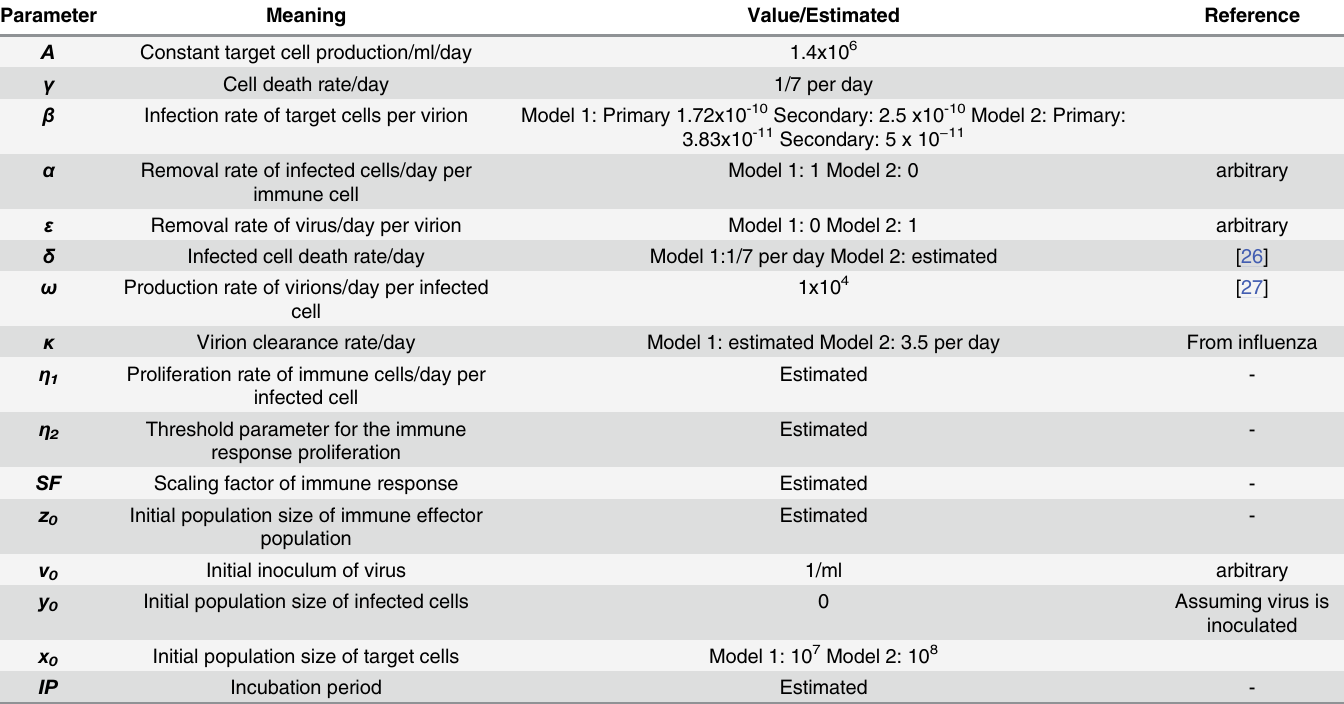
Table 4. The parameters of the model and values if fixed. References for fixed parameter assignments are given. Parameter Meaning Value/Estimated